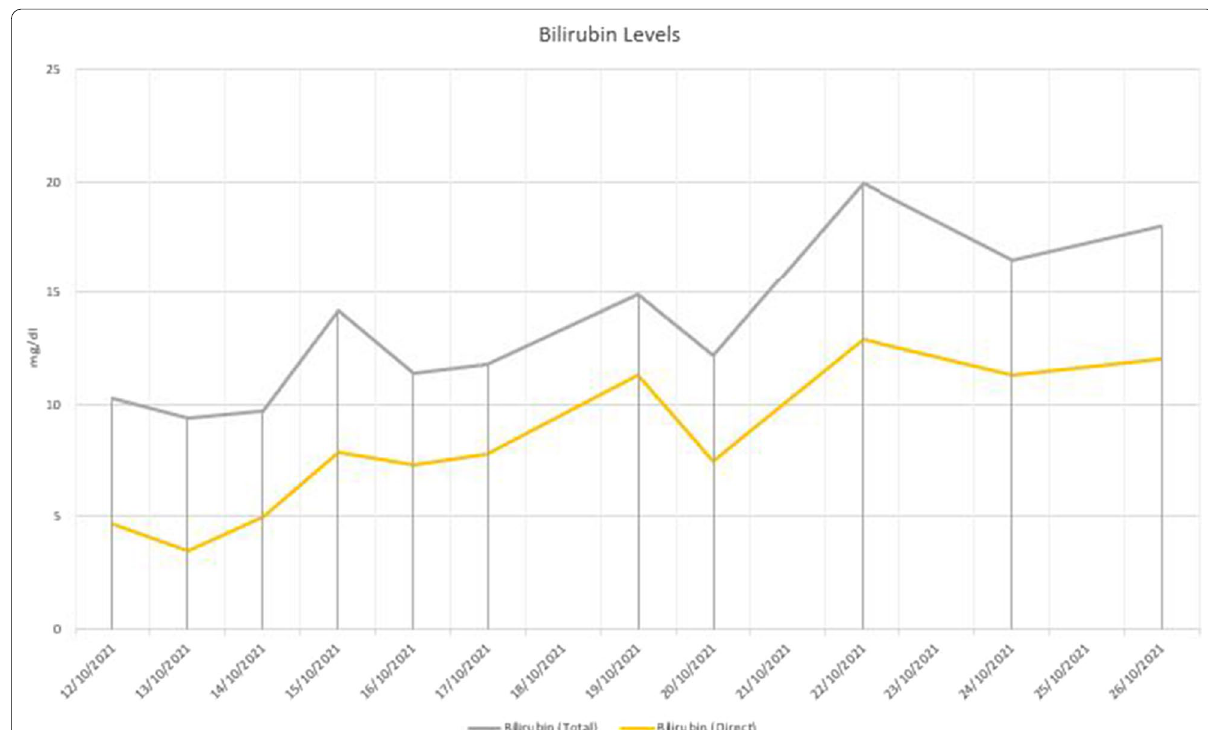
Fig. 3 Progression of bilirubin levels during the ICU stay. The transaminase levels dropped progressively, but the bilirubin levels were rising. Thrombocytopenia and haemolysis persisted even after the coagulopathy was corrected